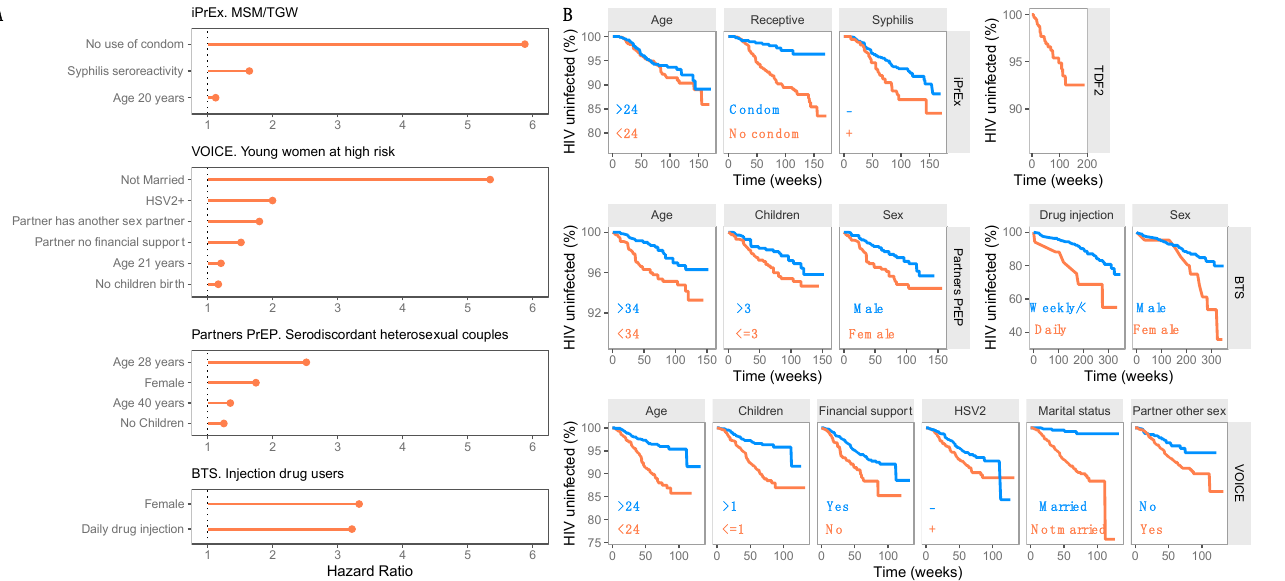
Figure 3 . Model predictors and evaluation. ( A ) Effect magnitude of each predictor on the relative risk (hazard ratio) of HIV infection for each population. ( B ) VPCs by studies and by covariates as a Kaplan–Meier plot of HIV probability. Lines represent raw data, and shaded areas cover the 95% prediction interval calculated from 200 simulated studies. No predictor effect is represented for TDF2 study, as no available predictor was included in the model.